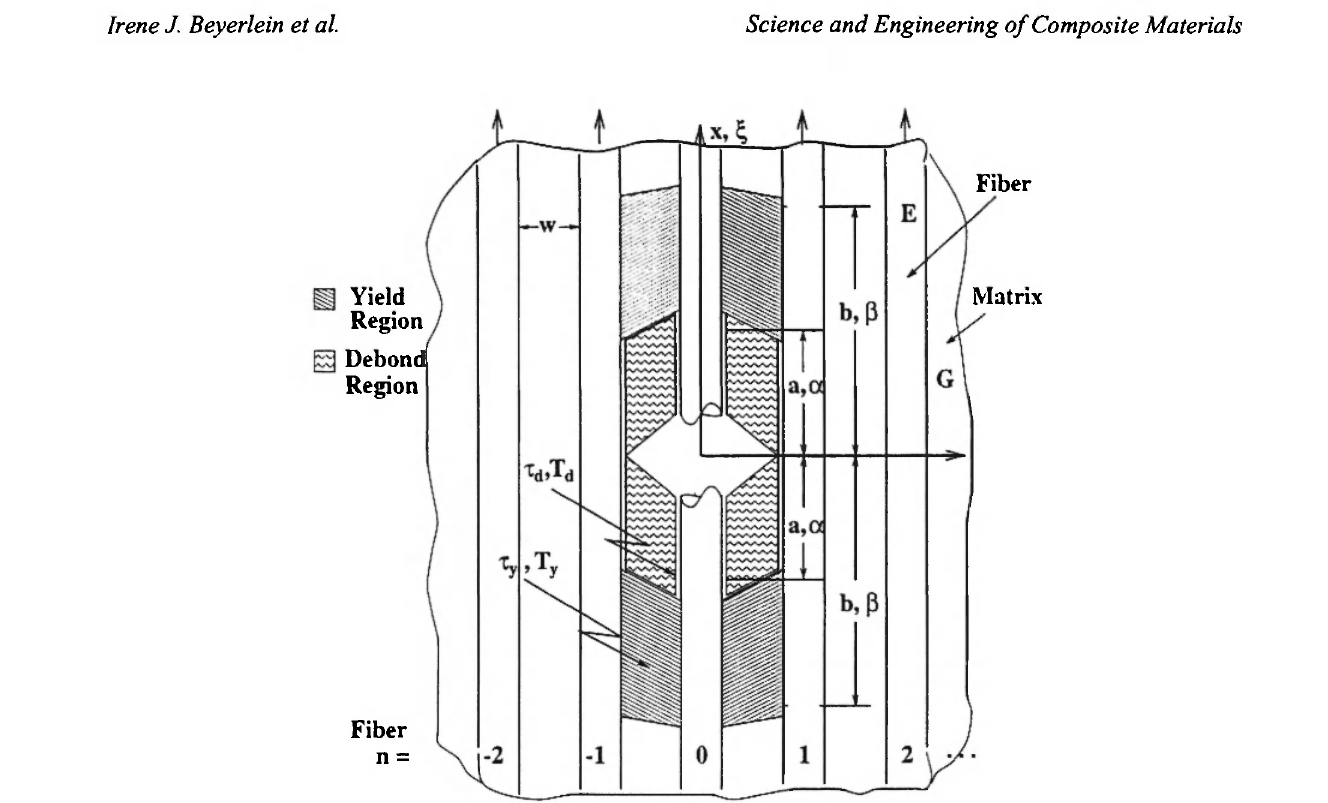
Fig. 1: Isolated break in an infinite lamina with yield zone (0 < χ < b) followed by a debond zone (0 < χ < a), and outside elastic (.v > b) zones subjected to a remote uniform tensile load. Notation includes both physical x, a, b, p, and dimensionless quantities, ξ, α, β, and P.